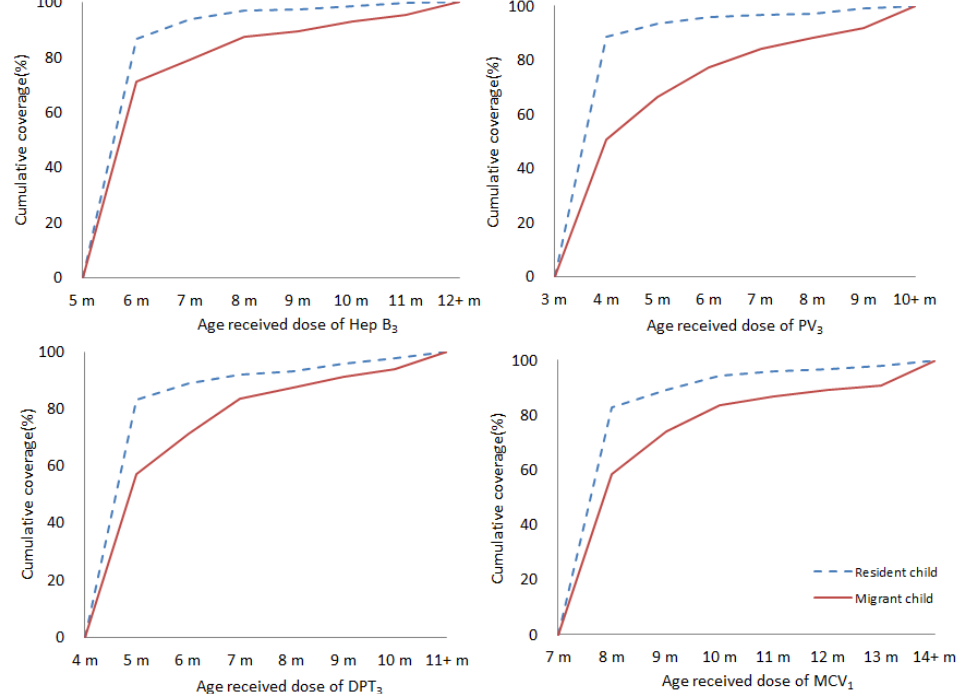
Figure 3. Timeliness of Hep B 2010. Percentage coverage = number of children who received vaccine dose at particular ages/the total number of children who received the vaccine dose (doses never administered or recorded were